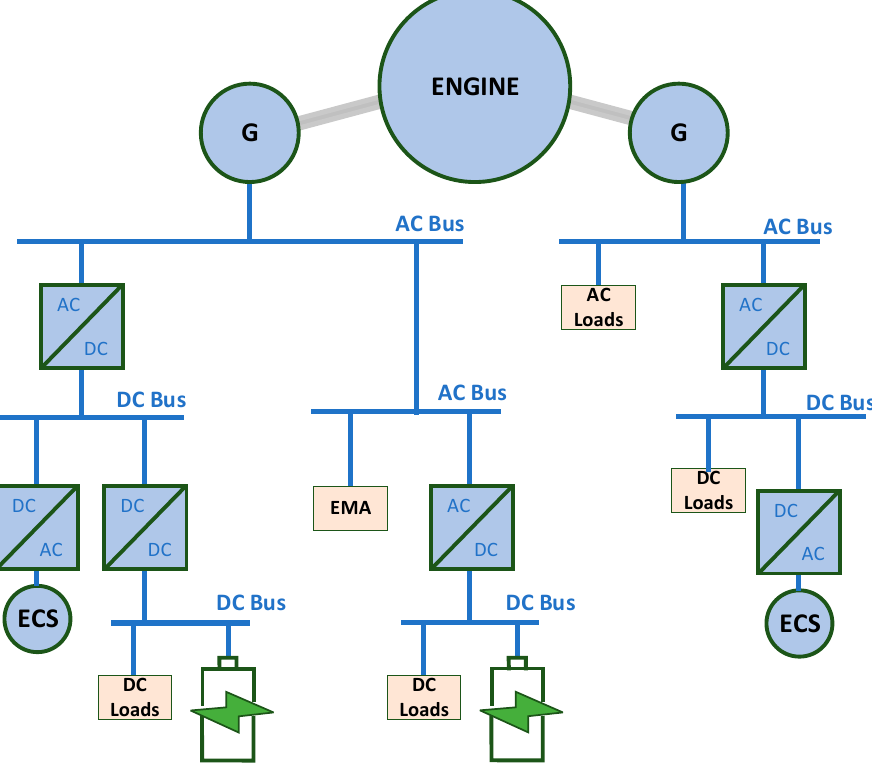
Figure 5. Simplified representation of the hybrid aircraft microgrid in the MOET project derived from [70].